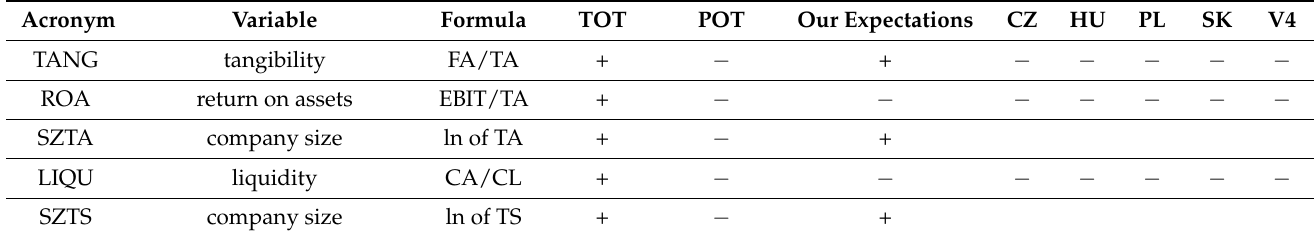
Table 8. Hypothesis